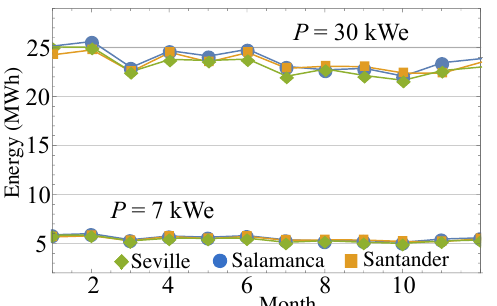
Figure 10. Monthly evolution of produced energy (recuperated layout) for the two levels of power output considered.